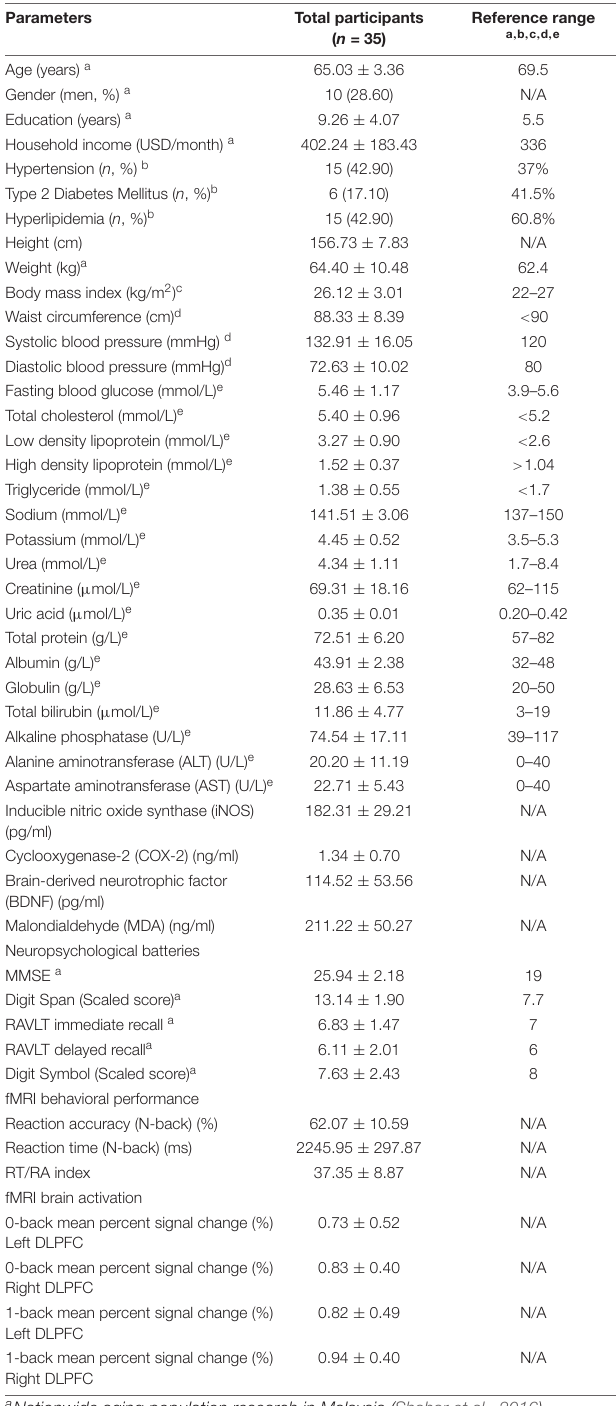
TABLE 1 | Demographic characteristics of total participants [expressed in mean ± SD or number (%)]. Parameters